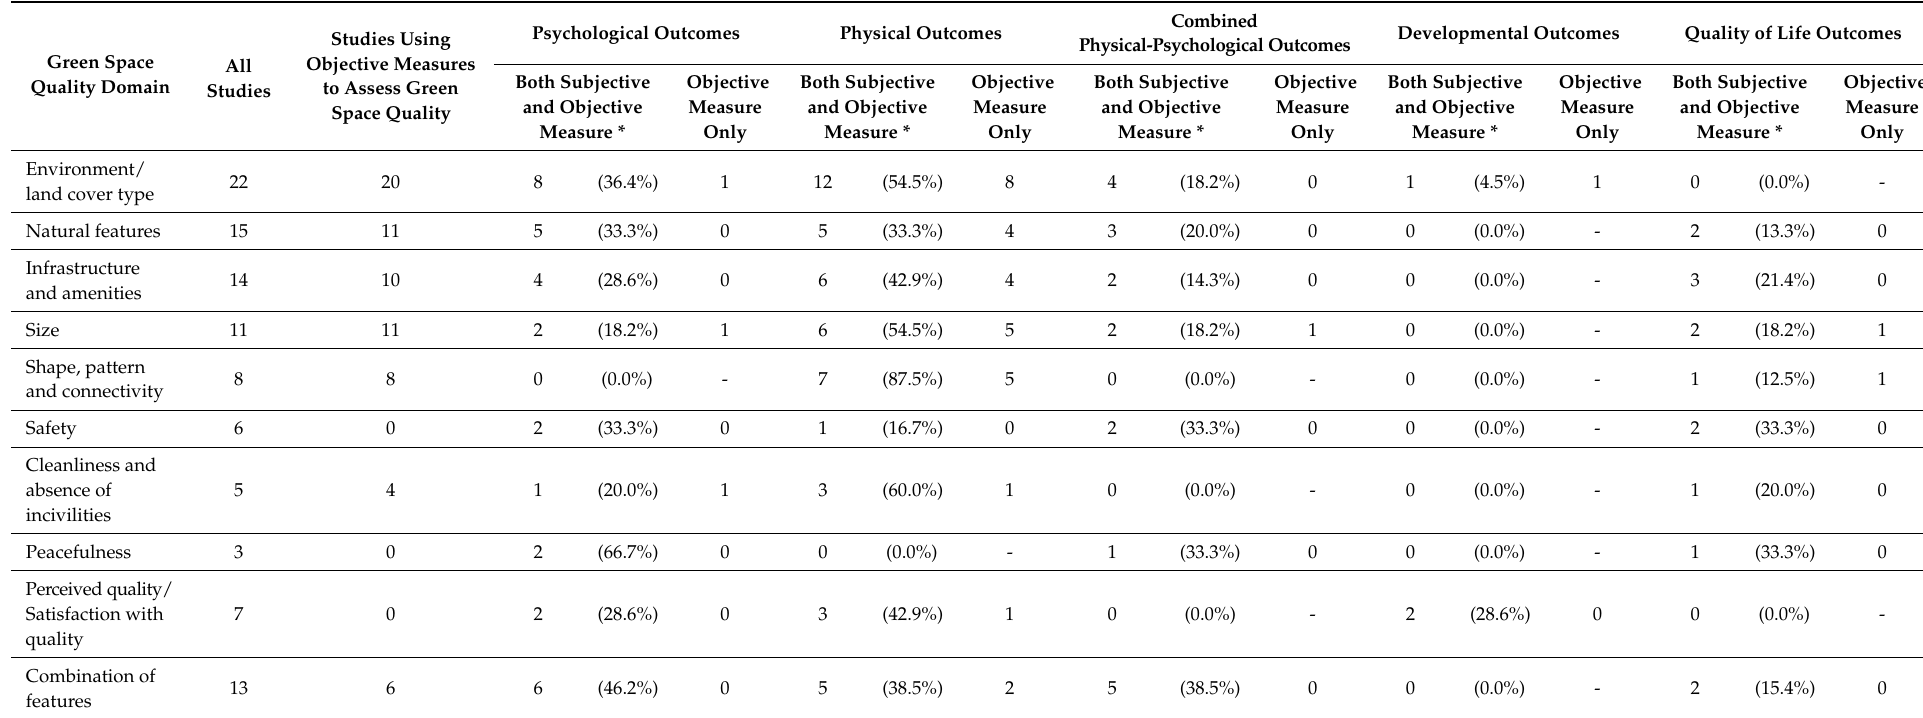
Table 2. Mapping of measures used for assessment of green space qualities and